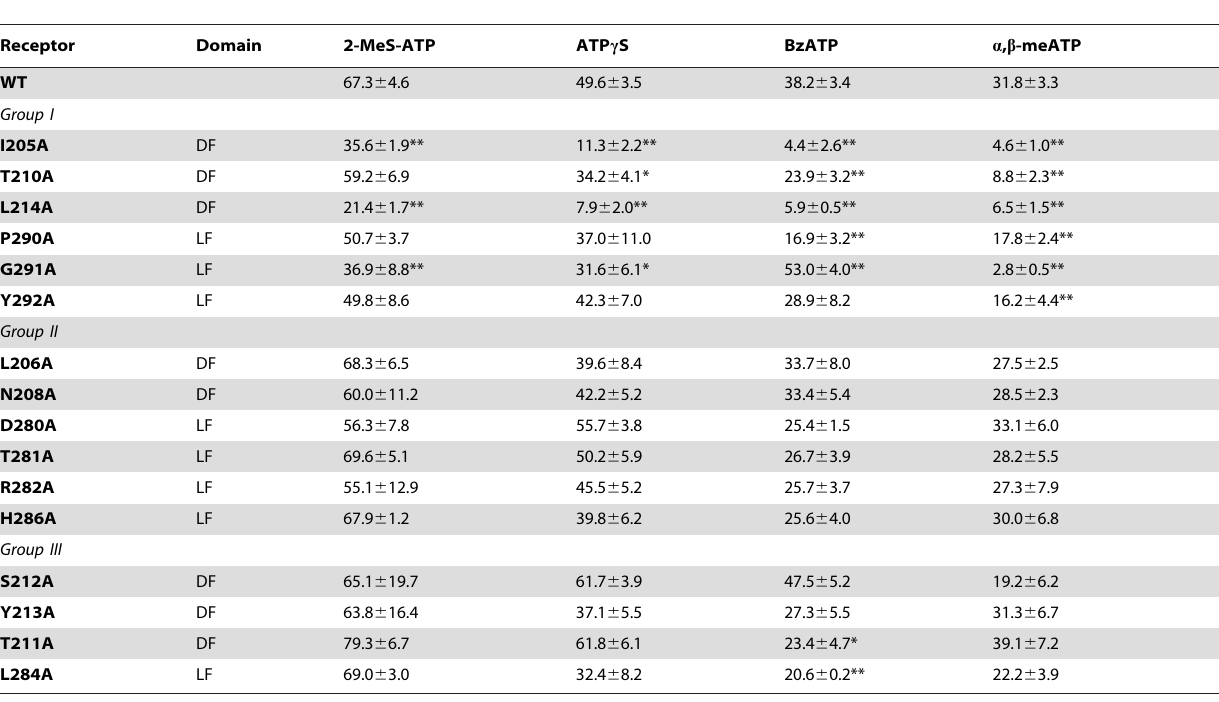
Table 2. The relative responsiveness of the wild type (WT) and selected rP2X4R mutants to P2XR agonist analogs.